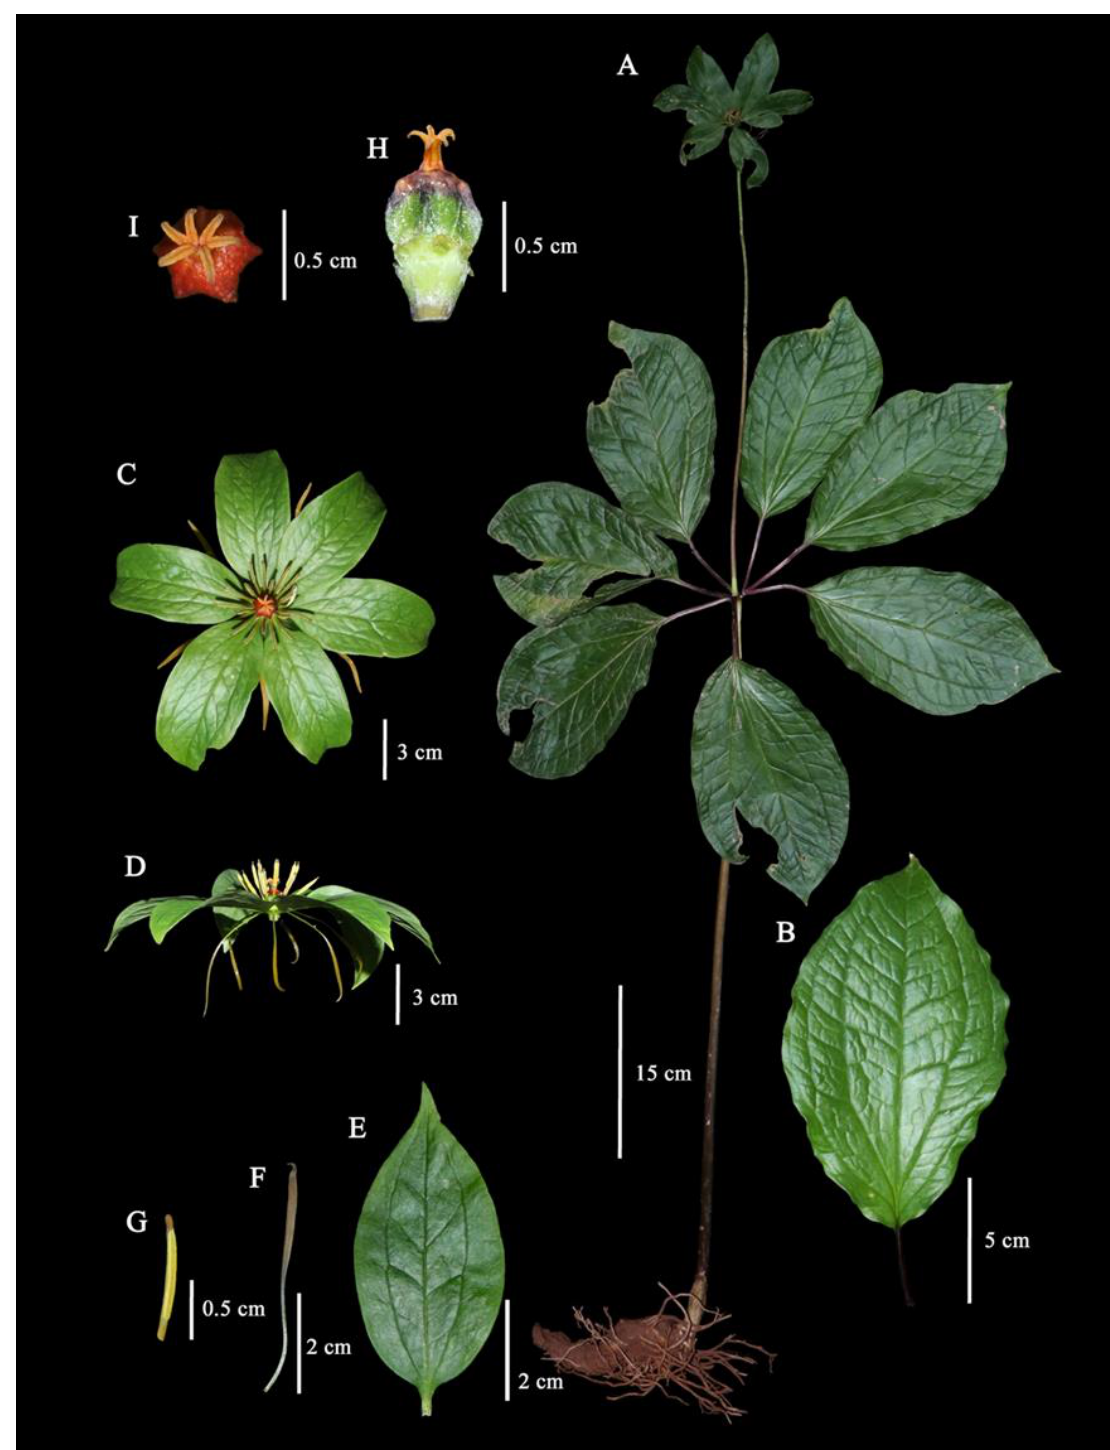
Figure 2. Paris siamensis Ruchis. (A) Habit, (B) Leaf, (C) Flower (front view), (D) Flower (lateral view), (E) Sepal, (F) Petal, (G) Stamen, (H) Pistil (front view), (I) Pistil (lateral view).